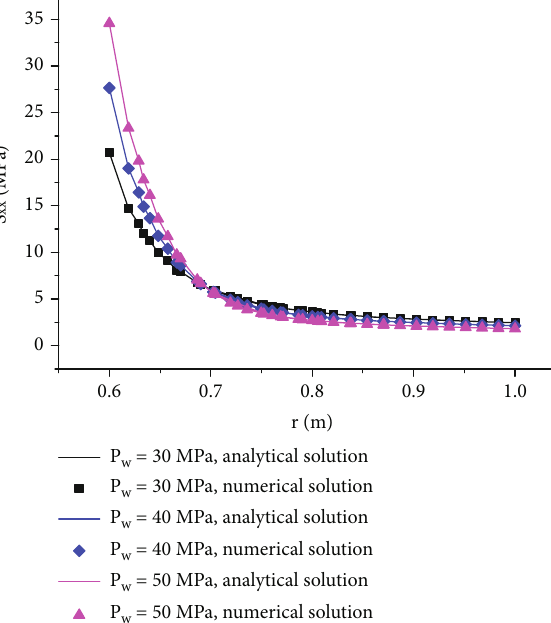
Figure 3: Numerical and analytical solutions to S component.